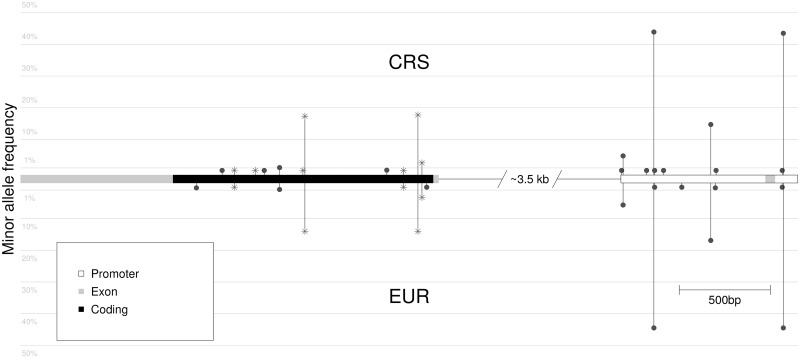
Comparison of variants found in 310 CRS patients and 379 EUR background population controls from the 1000Genomes project.Circles denote synonymous mutations and stars denote missense mutations. Intron 1 has been shortened by 3.5 kb to increase resolution.